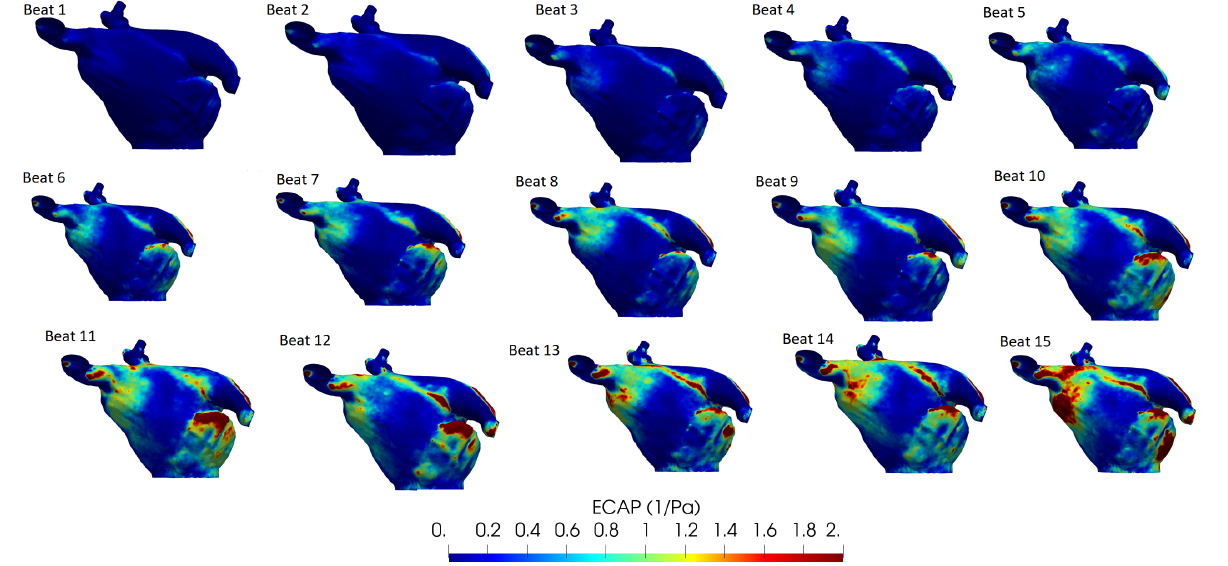
Figure 3. Endothelial cell activation potential (ECAP) maps for 15 simulated cardiac cycles/beats. Higher values (red colour) indicate a higher risk of